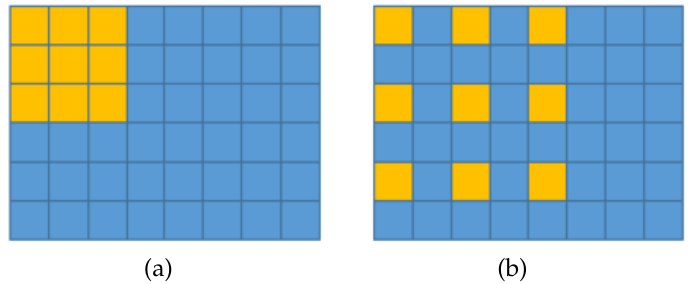
Figure 7. Concept of dilated convolution. ( a ) Dilation 1 and ( b ) dilation 2 are shown for a kernel of size 3 ×